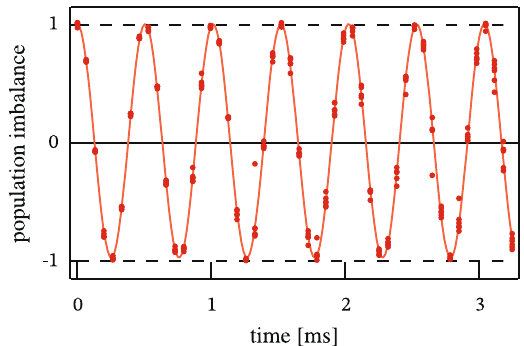
Fig. 8 Rabi-like oscillation between the two eigenstates. The population imbalance ( N g − N e )/( N g + N e ) was measured after the cyclic coupling for θ 2 = π /4 was abruptly turned on with the BEC in state 2 j i . The observed oscillation frequency of 2.0 kHz determines the energy gap of our